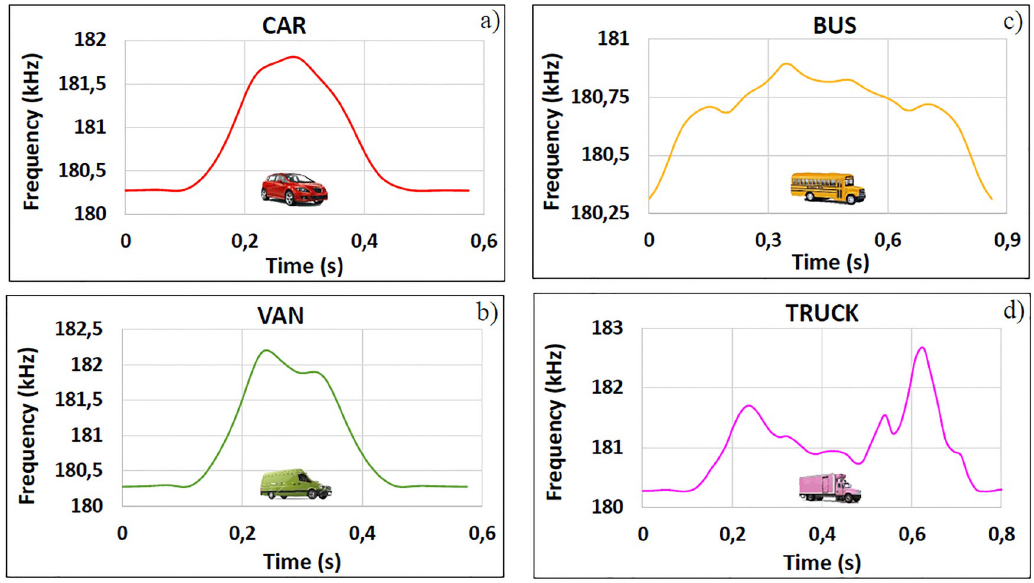
Fig 1. Real inductance signatures for (a) a car, (b) a van, (c) a bus and (d) a truck.